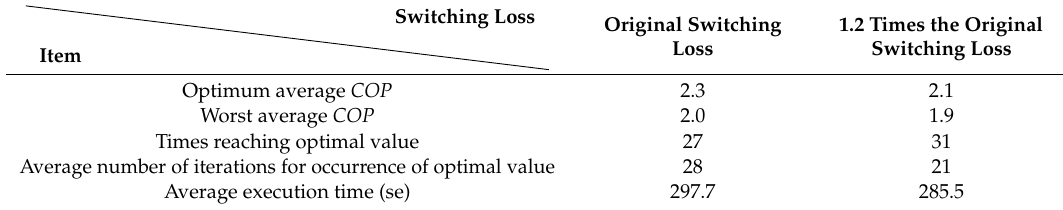
Table 8. Switching loss